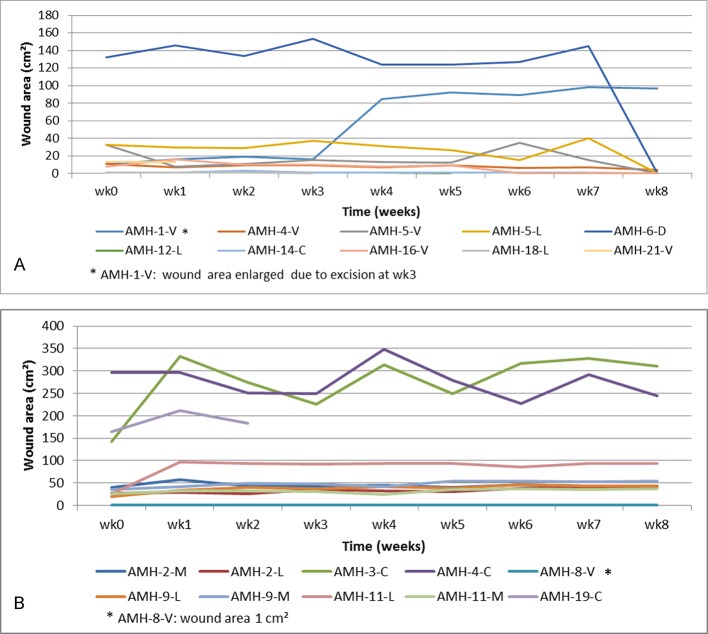
Development of IS2404 PCR positive ulcers measured by change in wound area over time at the SHC center (the patient code “AMH” refers to the patient numbering at the SHC center in Amasaman) A sub-chronic and healed ulcers B chronic non healing ulcers.